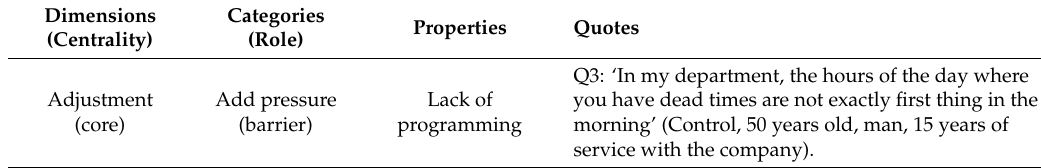
Figure 3. Dimensions, categories and properties determining the implementation of the WA-MBP-LS. Note : WA-MBP-LS: Workplace-adapted mindfulness-based programme for the logistics sector. Table 5. Quotes regarding the WA-MBP-LS implementation from participants point of view.